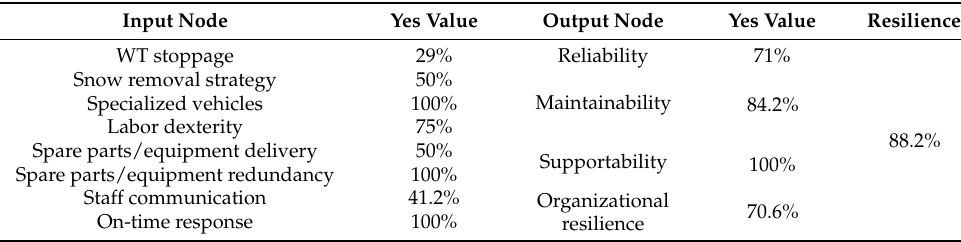
Table 4. Summary of input and output nodes in the Arctic operating conditions scenario.